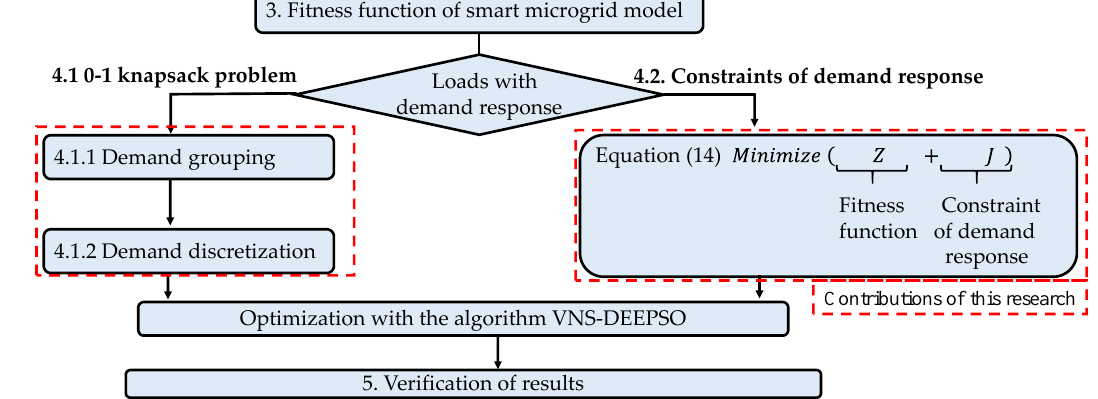
Figure 2. Conceptual formulation of a smart microgrid (SMG) with DR constraints.